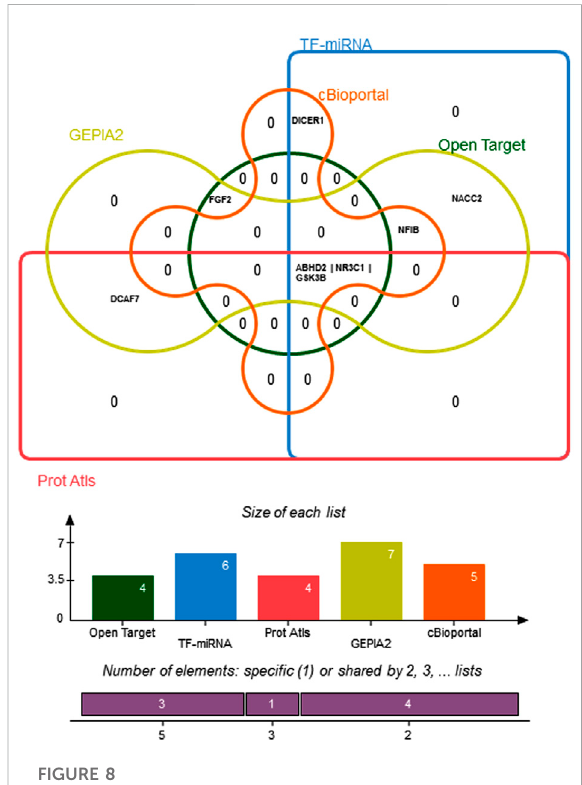
FIGURE 8 Edwards ’ Venn diagram demonstrating overlapping of hub genes across six system biology analysis methods. The bar graph represents the number of genes in each prediction